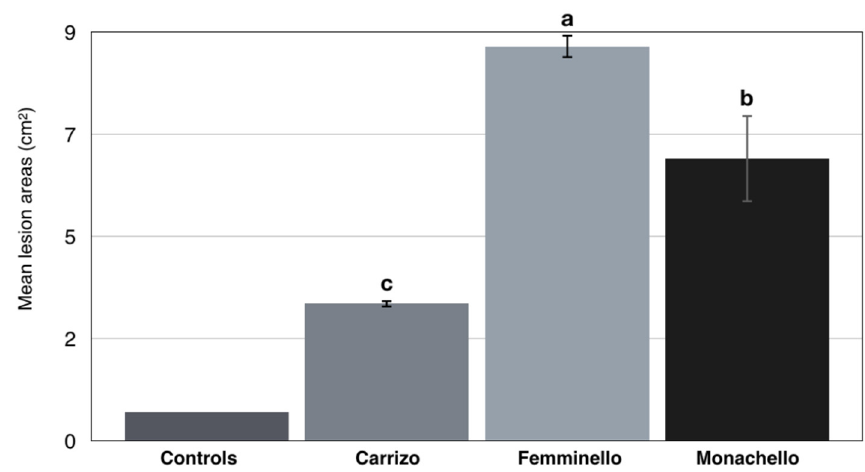
Figure 8. Mean lesion areas (cm 2 ) on the stem of citrange ( Citrus sinensis × Poncirus trifoliata ) ‘Carrizo’ and lemon ( Citrus × limon ) cultivars ‘Femminello 2kr’ and ‘Monachello’, wound-inoculated with isolate BOT1D of Neofusicoccum parvum , 30 d.a.i. Controls (‘Femminello 2kr’ lemon, ‘Monachello’ lemon and ‘Carrizo’ citrange) stem inoculated with a sterile agar plug, showed no symptoms. Values sharing different letters are statistically different according to Tukey’s honestly significant difference, for p = 0.05.